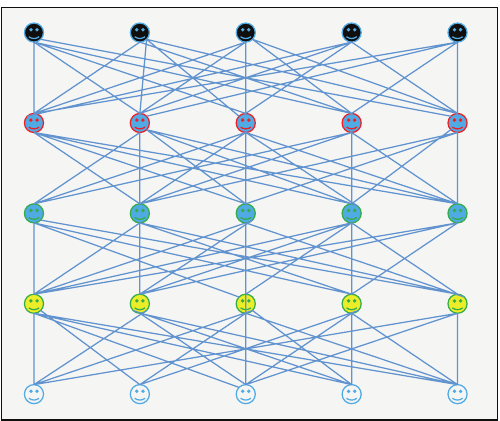
Figure 9: Network topology, adapted from Macal and North